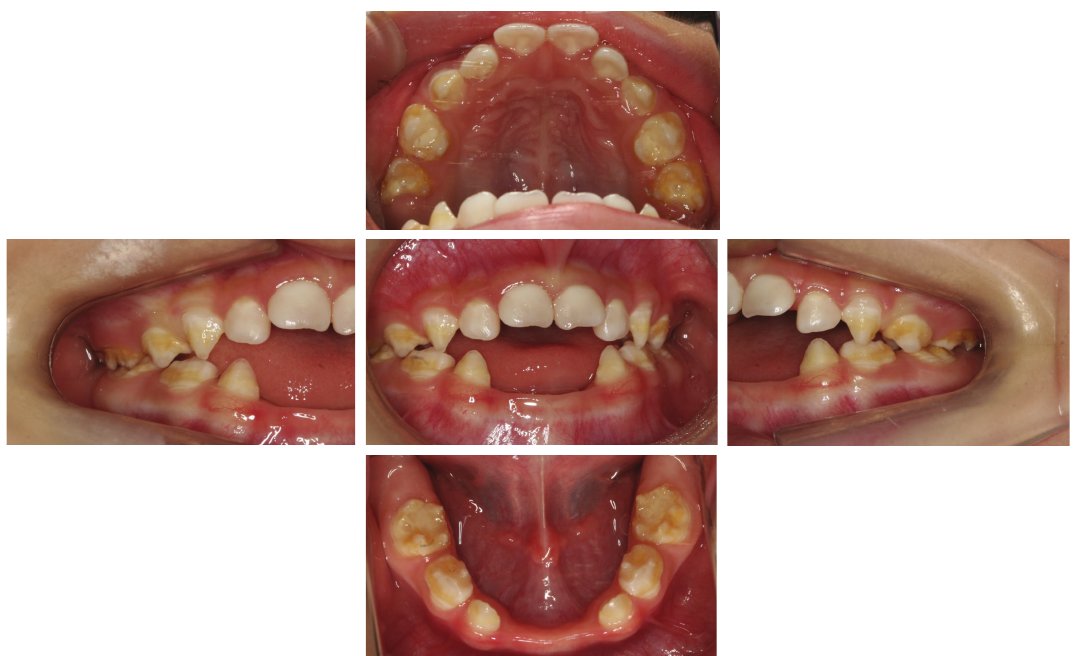
Figure 1: Clinical intraoral views at age of 3 years and 2 months.